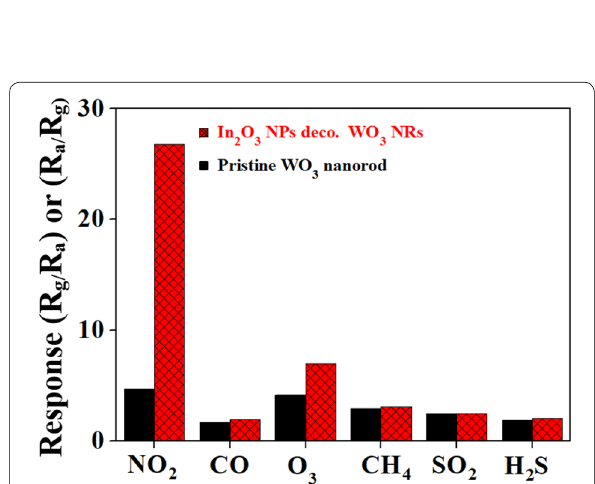
Fig. 8 Selectivity patterns of pristine and In 2 O 3 NPs‑decorated WO 3 NRs toward NO 2 against other gases such as O 3 , SO 2 , CO, CH 4 , and H 2